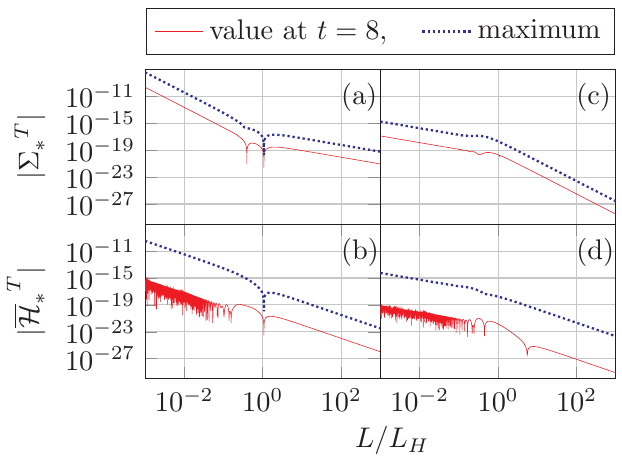
Figure 2. Generated tensorial perturbations as functions of the length scale using the background spacetime specified in Equation (163). Both the maximum amplitude and the values extracted at the integration time t = 8 are shown. In ( a , b ) the results using the initial conditions specified in Equations (168)–(170) are displayed, whilst ( c , d ) uses Equations (171)–(173), respectively. In all = 2 k = 2 k ( t 0 ) / √ 5, r B = 0.1. The initial resistivity was η ( t 0 ) = 10 − 3 in ( a , b ) and calculations, k ⊥ (cid:107) η ( t 0 ) = 1 in ( c , d